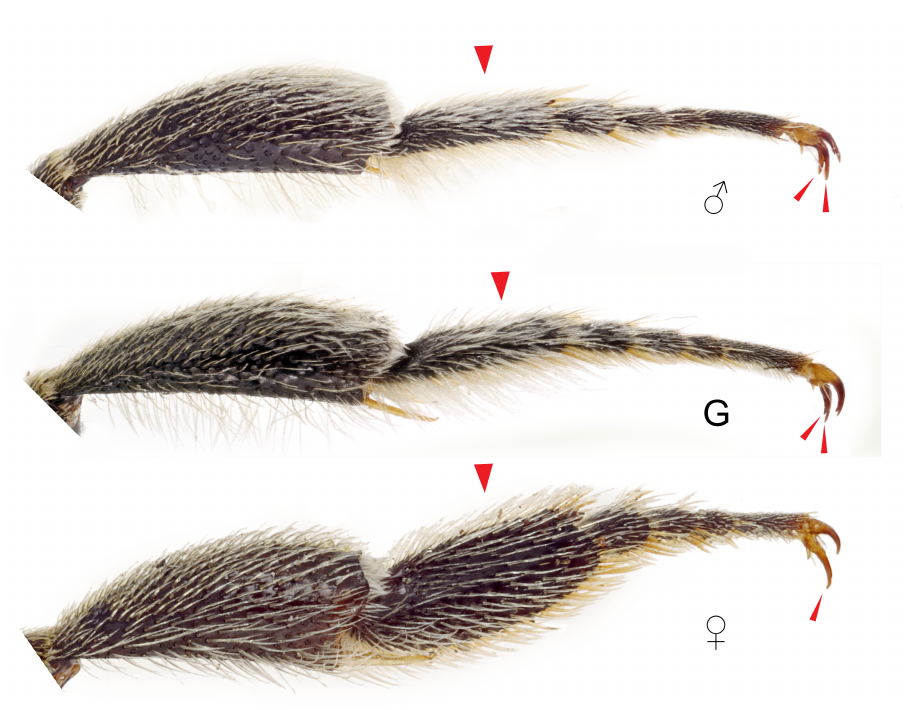
Figure 7. Hind legs of Megachile pilidens , lateral view: Arrowheads indicates differences in morphology and setation of the first metatarsus and in the shape of the